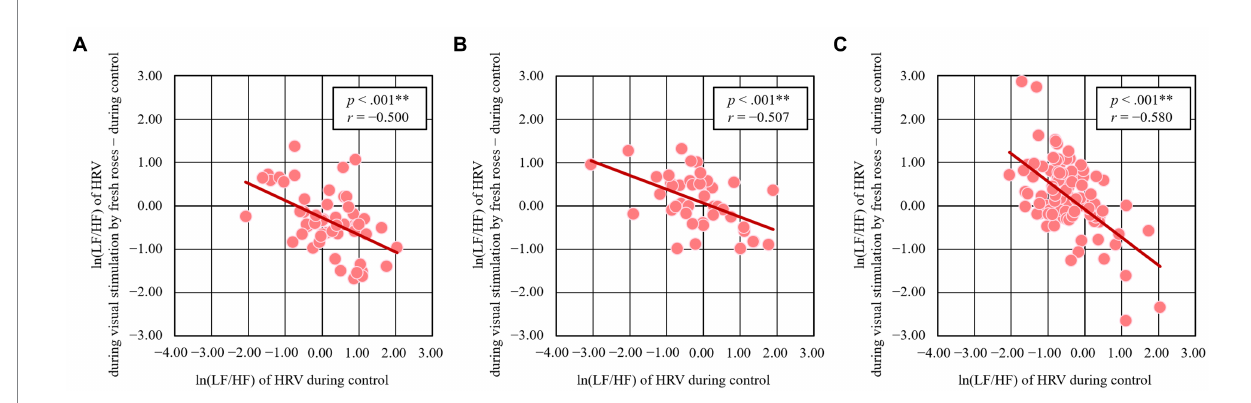
FIGURE 4 Relationship between the initial value and change in ln (LF/HF) of HRV induced by visual stimulation with fresh roses organized by group. (A) High school students, N = 55, ** p < 0.001 (B) office workers, N = 45, ** p < 0.001, and (C) elderly people. N = 100, ** p < 0.001 by Pearson’s correlation.